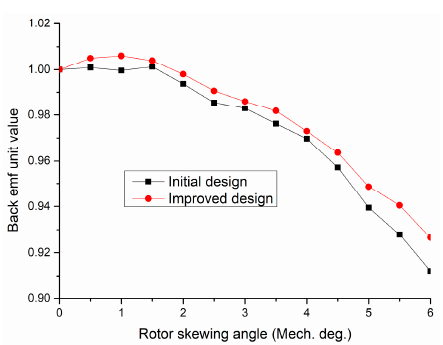
Figure 10. Back EMF comparison of the CPM with the a different magnet skewing angle; initial design is with the equal claw pole teeth width design as shown in Figure 1, and improved design is with the optimized unequal stator claw pole structure.